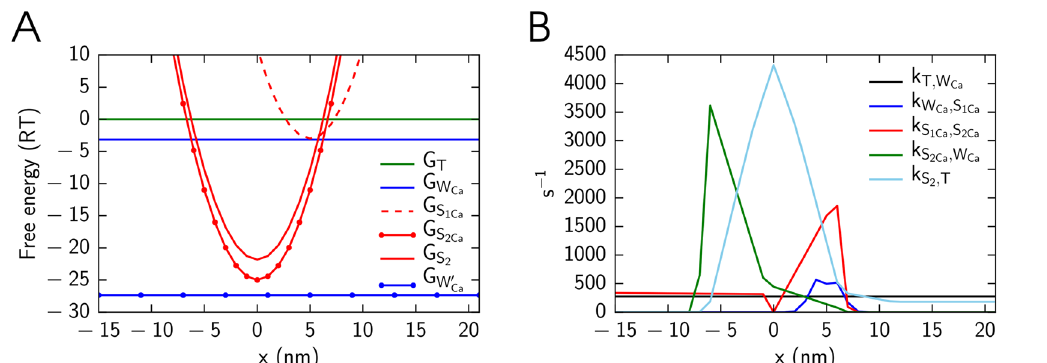
Fig 4. Free energy profiles (A) and cross-bridge forward rate constants (B). The model parameters were found by optimization procedure for the model with cooperativity induced by tropomyosin deformation ( q = 3).